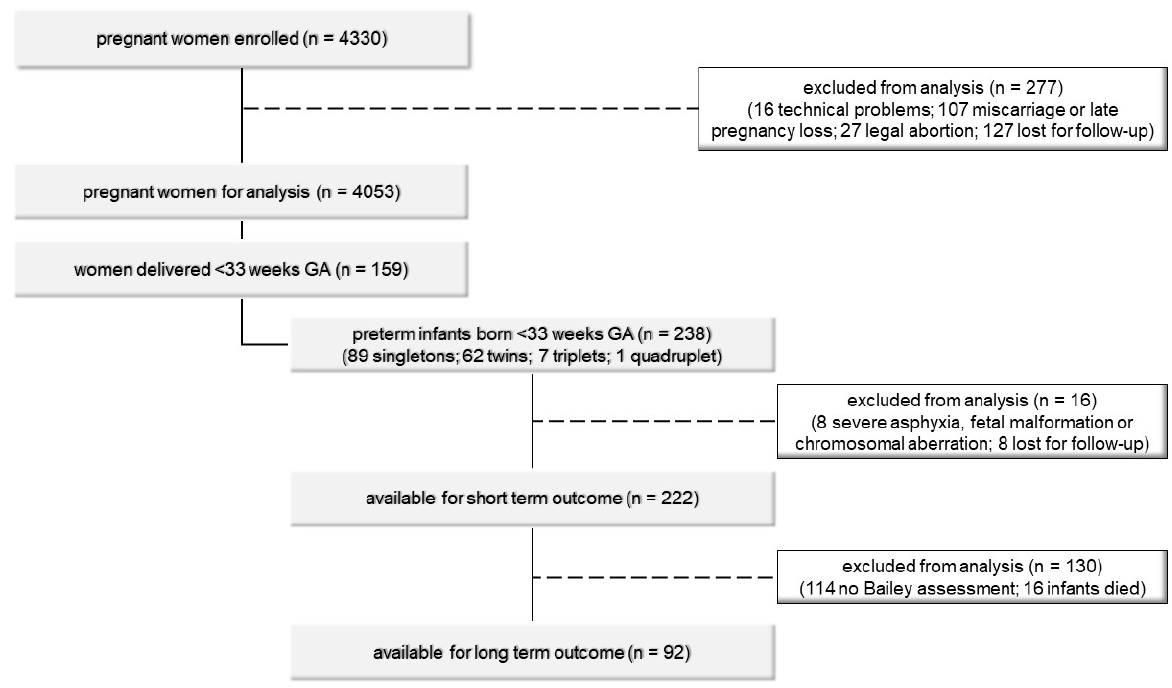
Figure 1. Patient flow